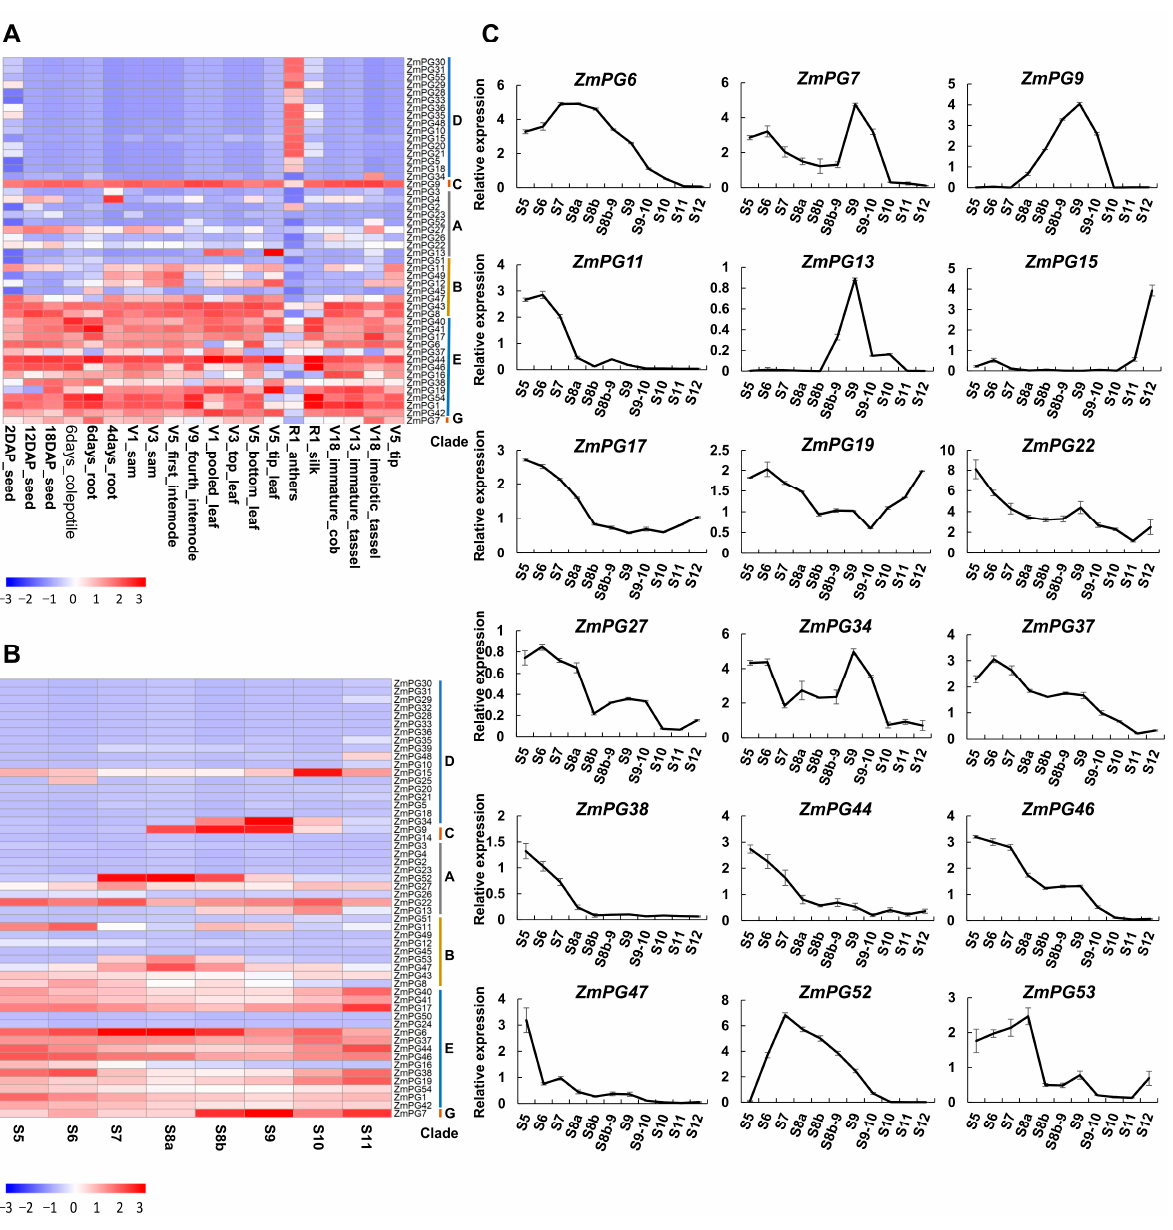
Figure 4. Expression profiles of ZmPGs . ( A ) Hierarchical clustering and heat map showing the expression levels of ZmPGs from 20 maize tissues. The vertical bar on the right illustrates the six groups of ZmPGs . ( B ) Hierarchical clustering and heat map showing the expression levels of ZmPGs at eight stages of anther development by transcriptome analysis. The vertical bar on the right illustrates the six groups of ZmPGs . The color scale bars represent the relative expression level of ( A , B ). ( C ) Relative expression of 18 ZmPGs from developmental anther stages 5 to 12 (S5–S12) detected by RT-qPCR. Each bar represents the mean and SD of three repeats. Similar results were obtained from three independent biological experiments.